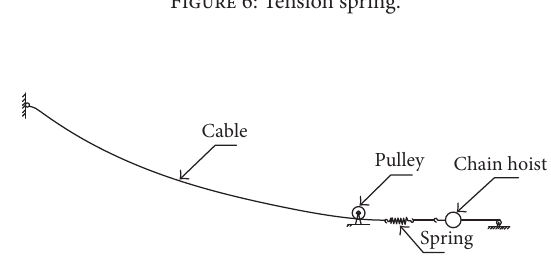
Figure 6: Tension spring.